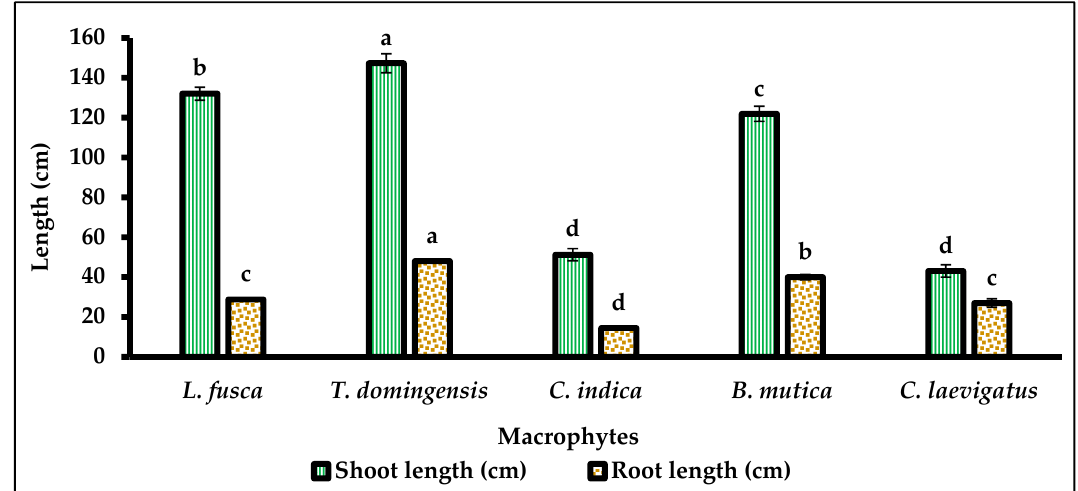
Figure 4. Relative growth pattern of different macrophytes in constructed wetlands fed with tannery effluent. Error bars indicate standard deviation among three replicates. Labels (a)–(d) indicate statistically significant differences ( p < 0.05) within plant tissues across species at a 5% level of significance.